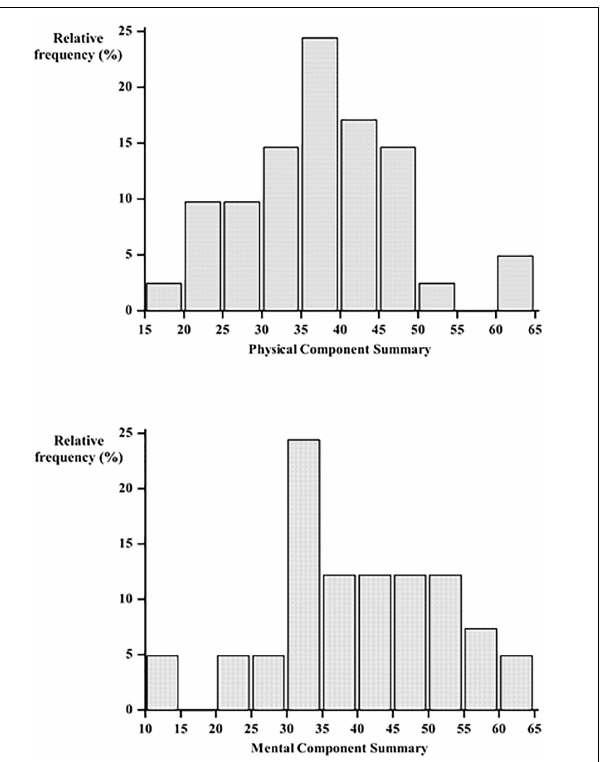
FIGURE 1 | Distribution of Physical Component Summary (PCS) and Mental Component summary (MCS) measured by the Short Form-36 (SF-36).